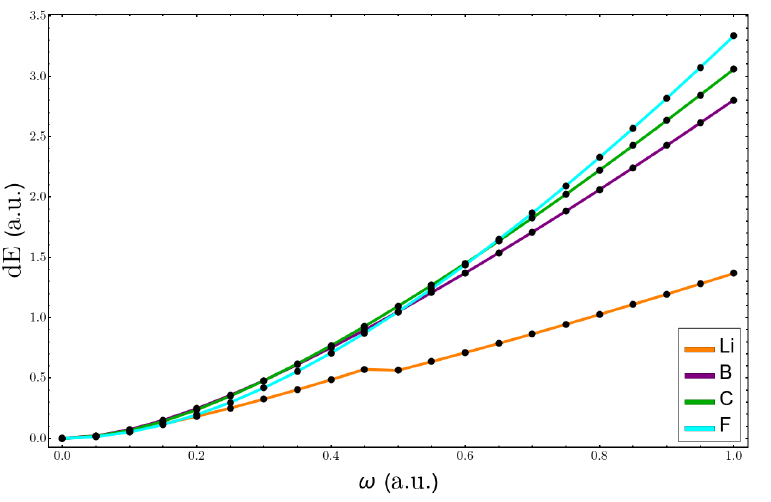
Figure 6. Change in the total energy with confinement, using Equation (11), for Li, B, C, and F atoms.